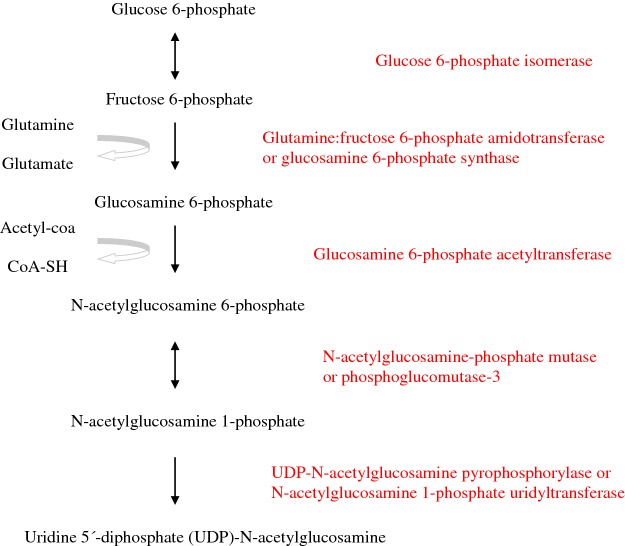
Hexosamine pathway